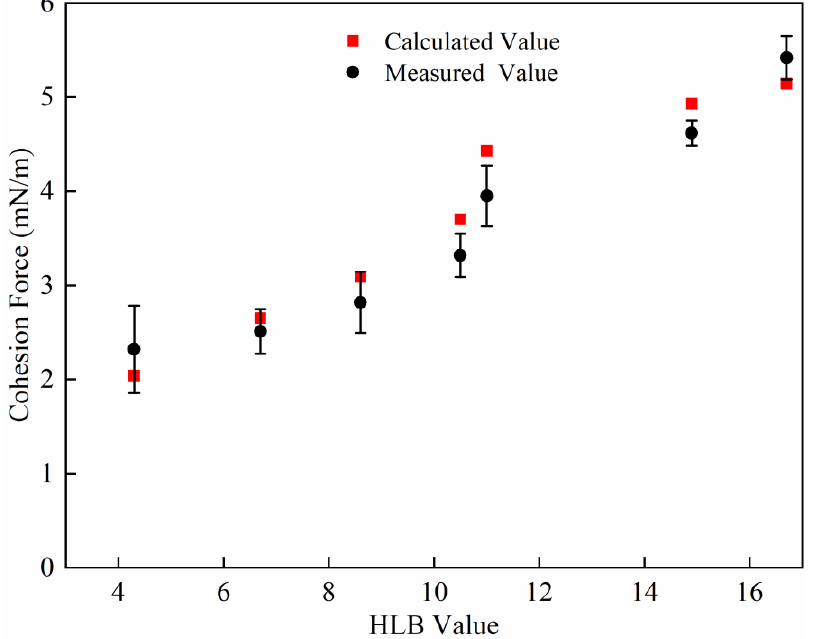
Figure 6. Variations of cohesive force between cyclopentane hydrates as a function of HLB value.